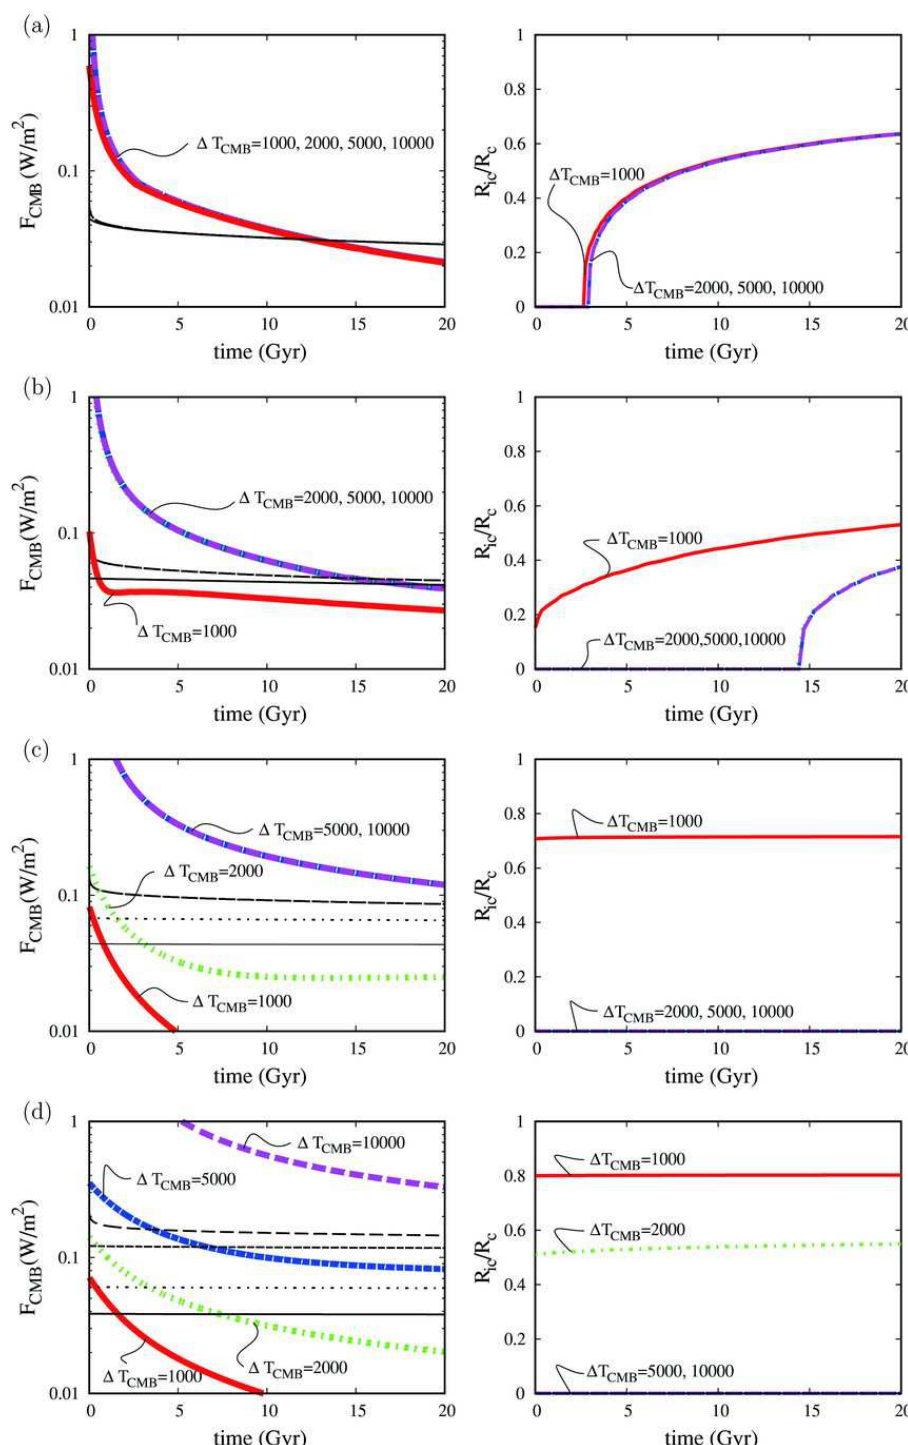
Figure 8. Evolution of the Q CMB (left column) and R ic (right column) for M = (a) 1, (b) 2, (c) 5, and (d) 10 M ⊕ with different initial ∆ CMB . Left column: critical flux of heat for each ∆ is expressed by a thinner line of the same type. Some lines with different initial ∆ CMB lapped by each other. For these parameters, the initial conditions do not affect the evolution because self-regulation of mantle heat transfer works due to temperature dependence of mantle viscosity. Inner cores never nucleate in the cases of ∆ M p = 5 M ⊕ and ∆ CMB = 5000 and 10,000 K for M p = 10 M ⊕ . (Figure from TA11, with permission of the